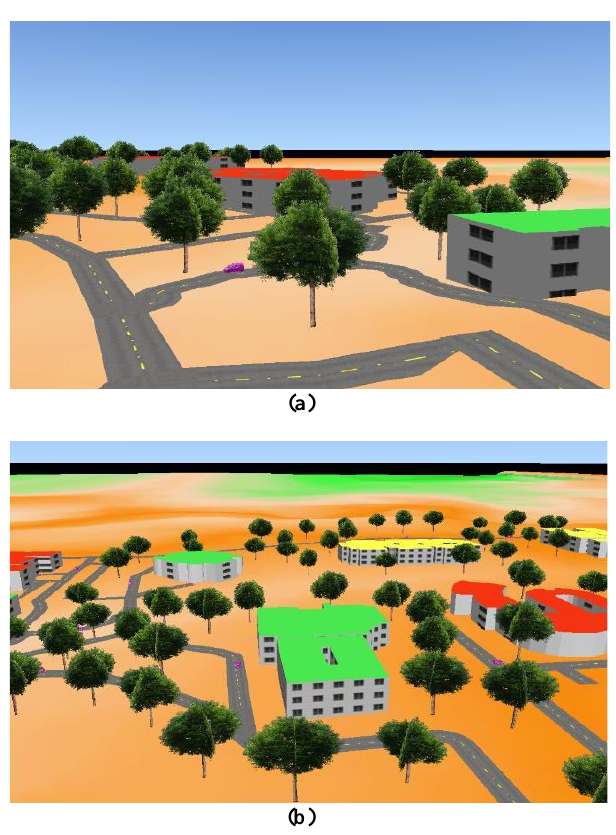
Figure 6. Snippets of the 3D Animation: (a) towards the Institute of Mathematics building; and (b) overview of buildings in western side of the